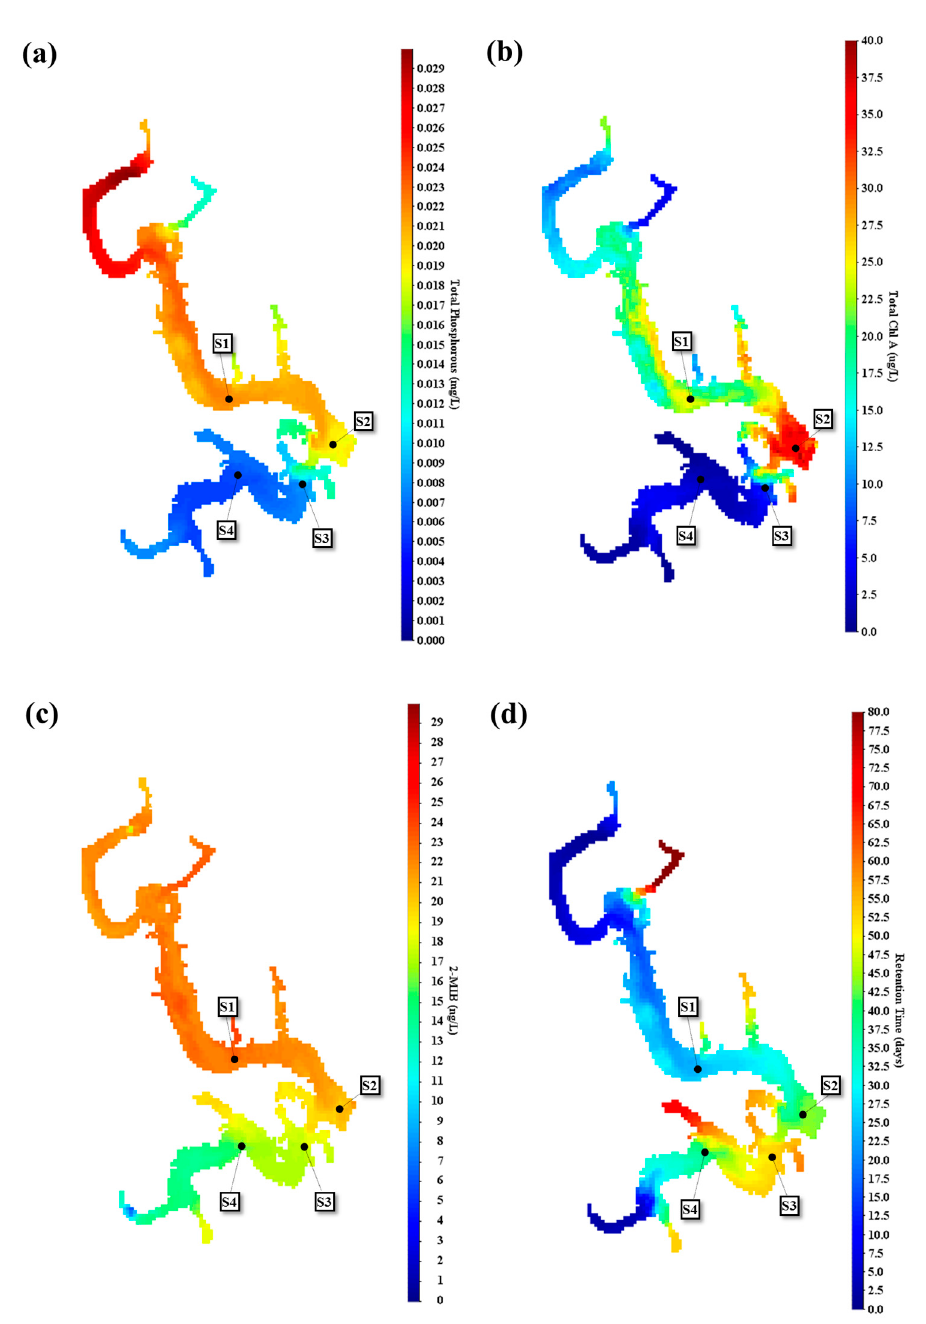
Figure 8. Spatial distribution of water quality and taste and odor compounds during algal bloom occurrence (21 June 2016): ( a ) TP, ( b ) chlorophyll-a, ( c ) 2-MIB, and ( d ) retention time.